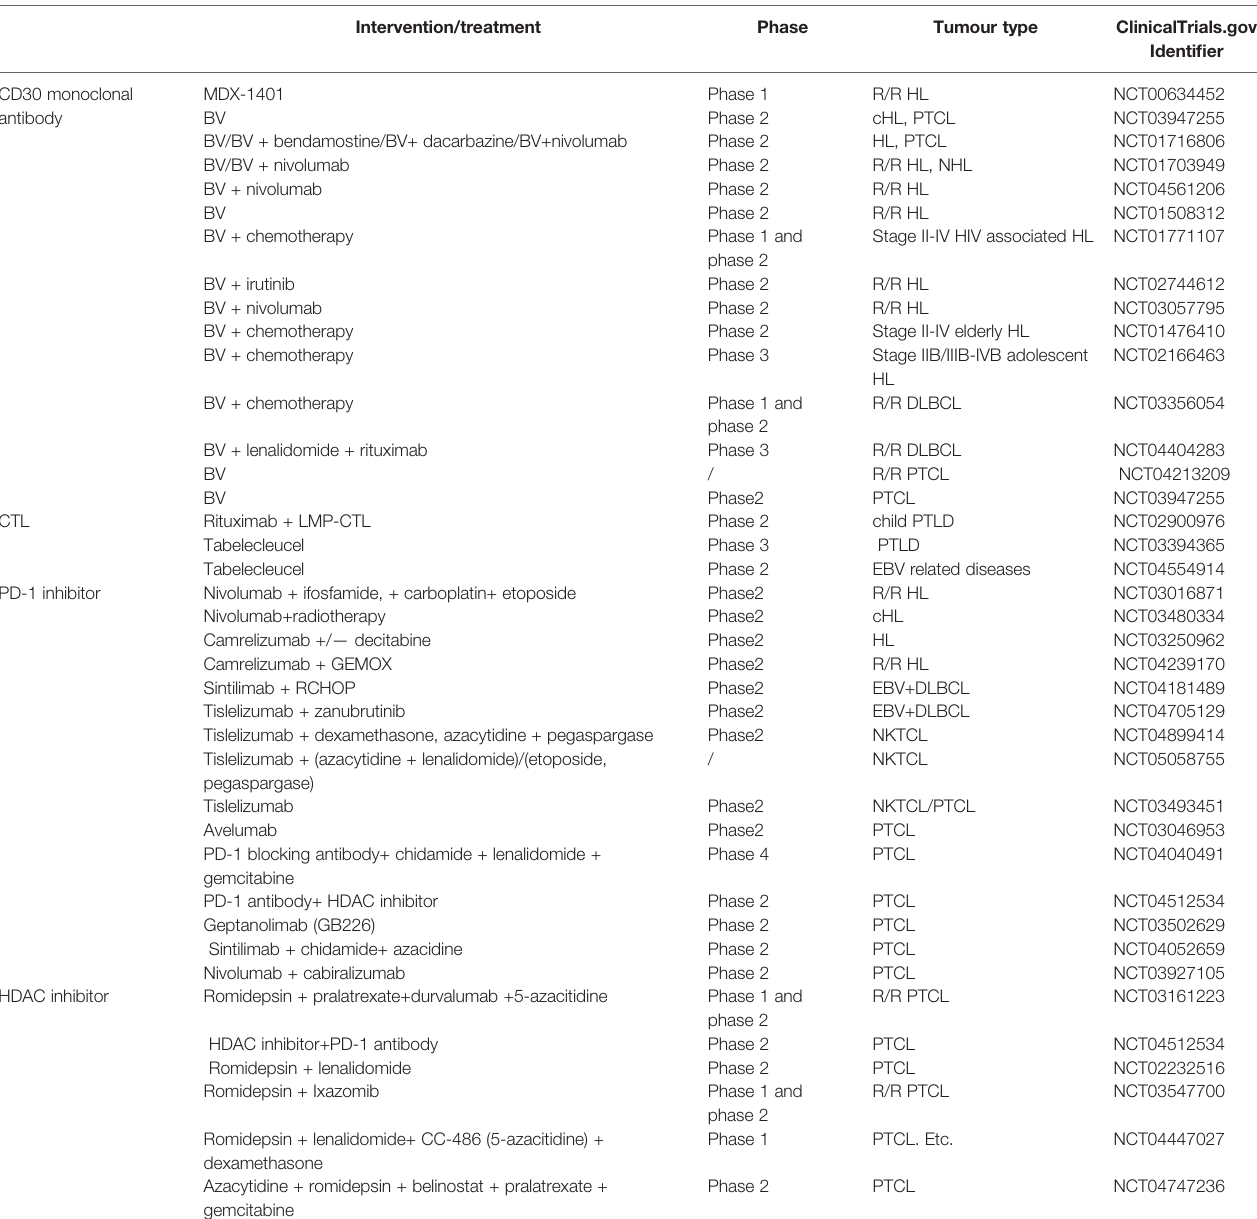
TABLE 3 | Clinical trials of therapy for EBV